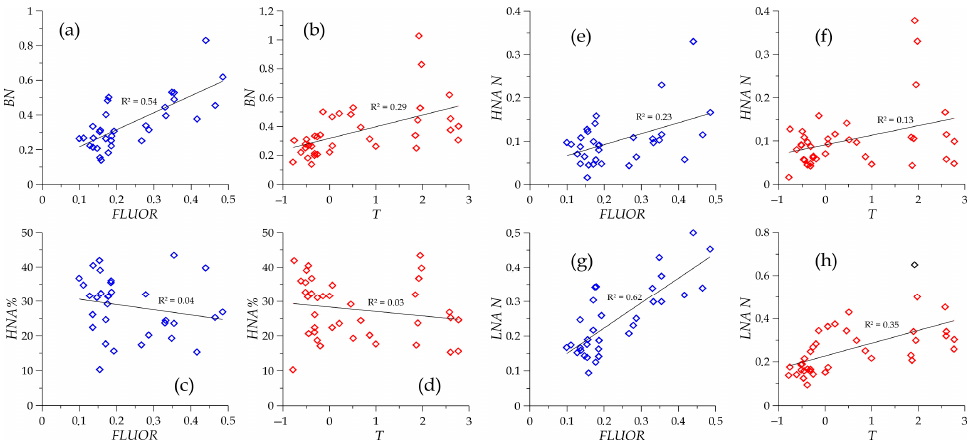
Figure 9. Relationships between bacterioplankton ( BN , 10 6 cells mL − 1 ), HNA-bacteria ( HNA N , 10 6 cells mL − 1 ), LNA-bacteria ( LNA N , 10 6 cells mL − 1 ), the fraction of HNA-bacteria ( HNA% ), water temperature ( T , °C), and chlorophyll a fluorescence ( FLUOR , rel. u.).